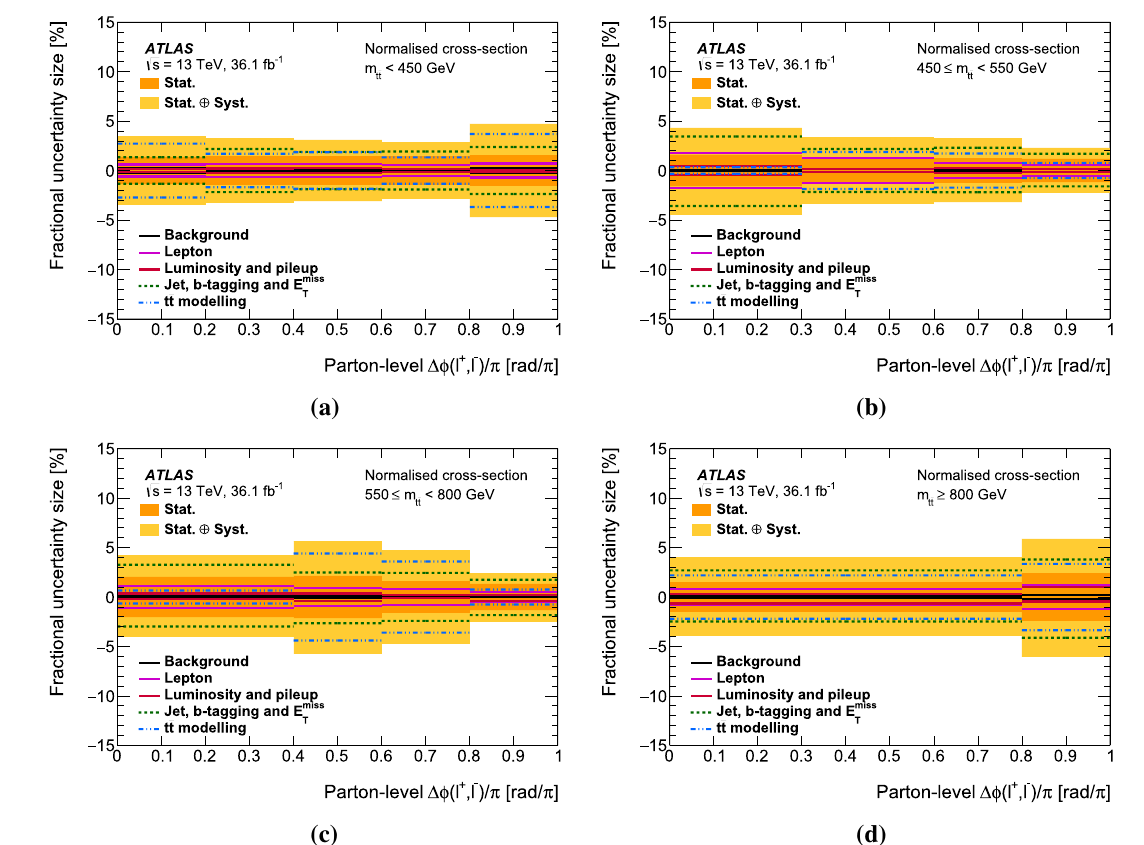
Fig. 9 Systematic uncertainties for the normalised parton-level dif- ferential cross-sections in four t ¯ t mass bins: a m t ¯ t < 450 GeV, b